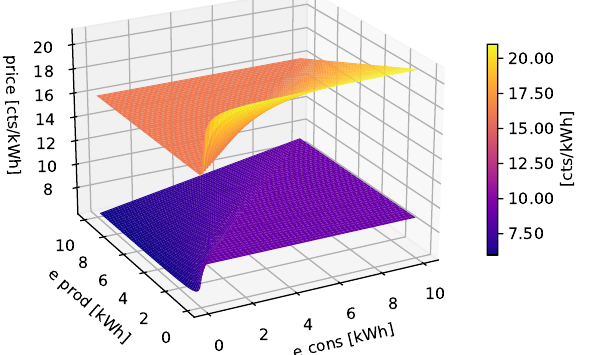
Figure 4. Buying ( upper surface ) and selling price ( lower surface ) p b and p s as a function of the produced and consumed energy inside the